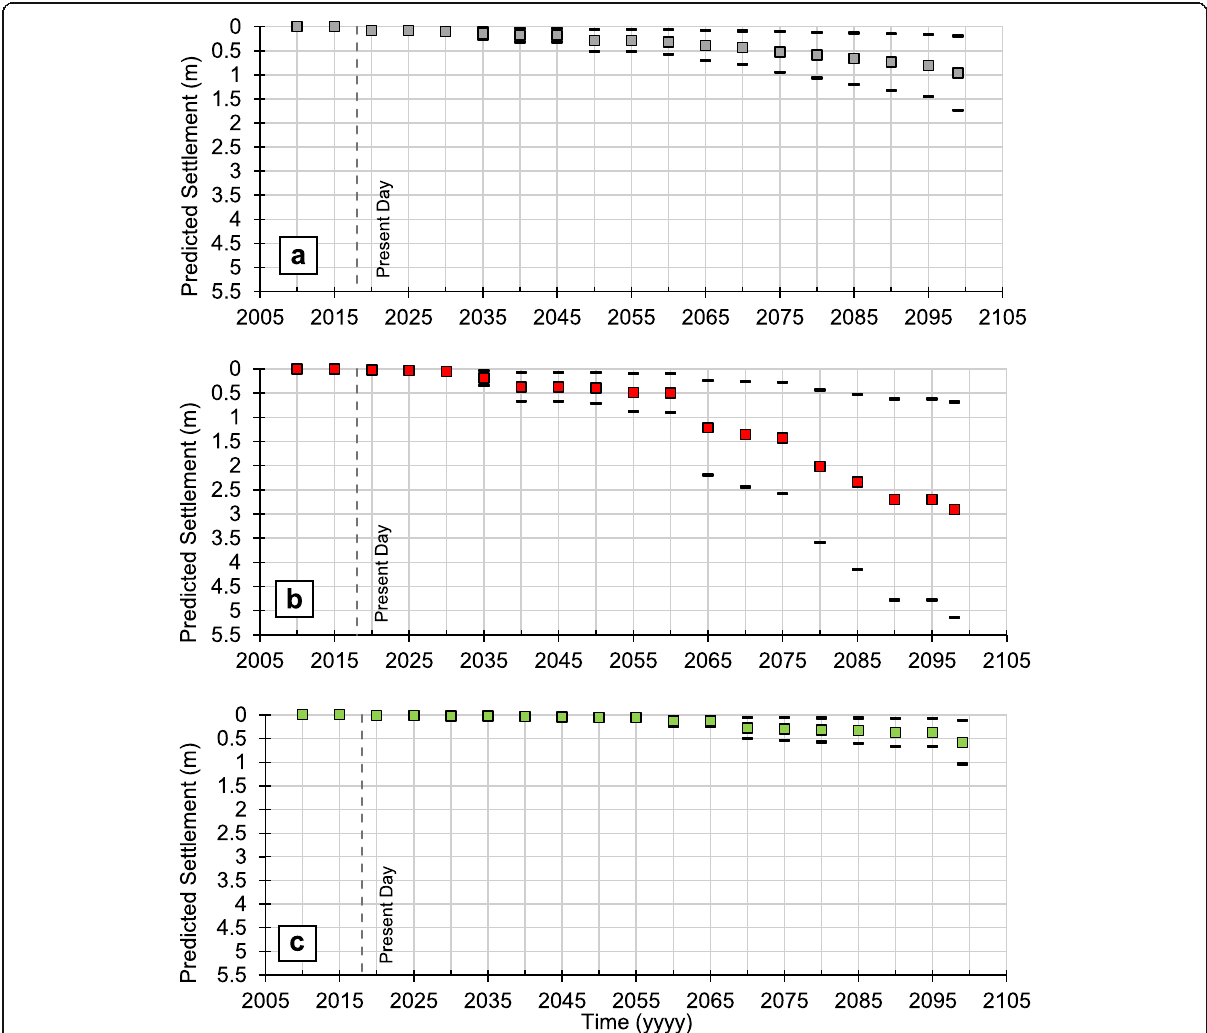
Fig. 13 Predicted settlement at the study site due to active layer thickening under disturbed ground surface conditions where the organic layer was replaced with gravel fill: a 28 climate model average; b BNU-ESM upper bound climate model; c CMCC-CESM lower bound climate